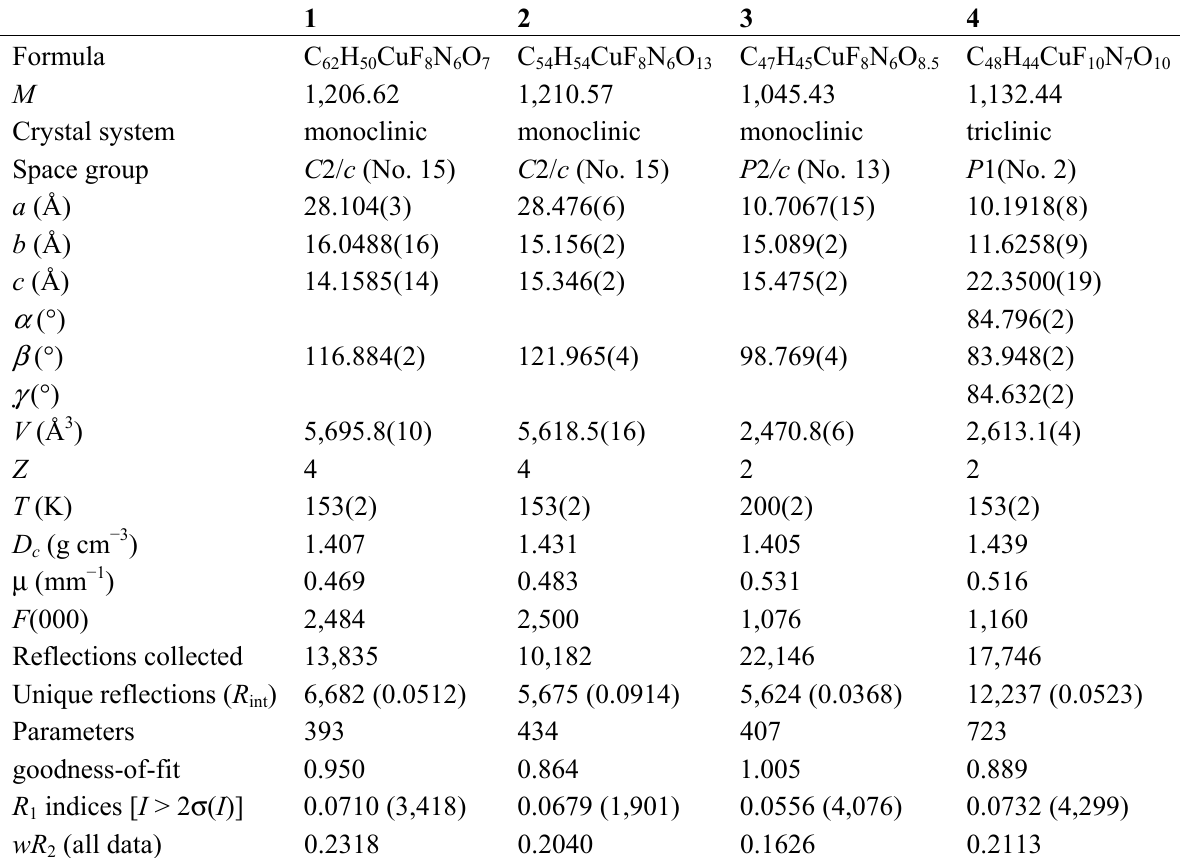
Table 3. Crystallographic data for 1 – 4